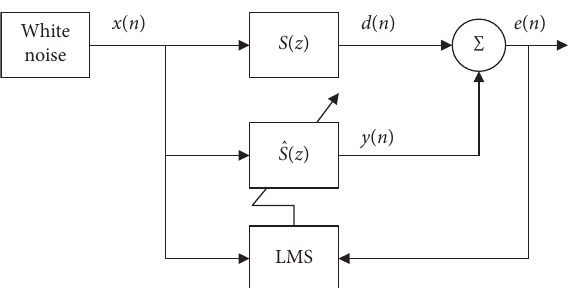
Figure 10: Identification of the secondary path using FIR filters [131,